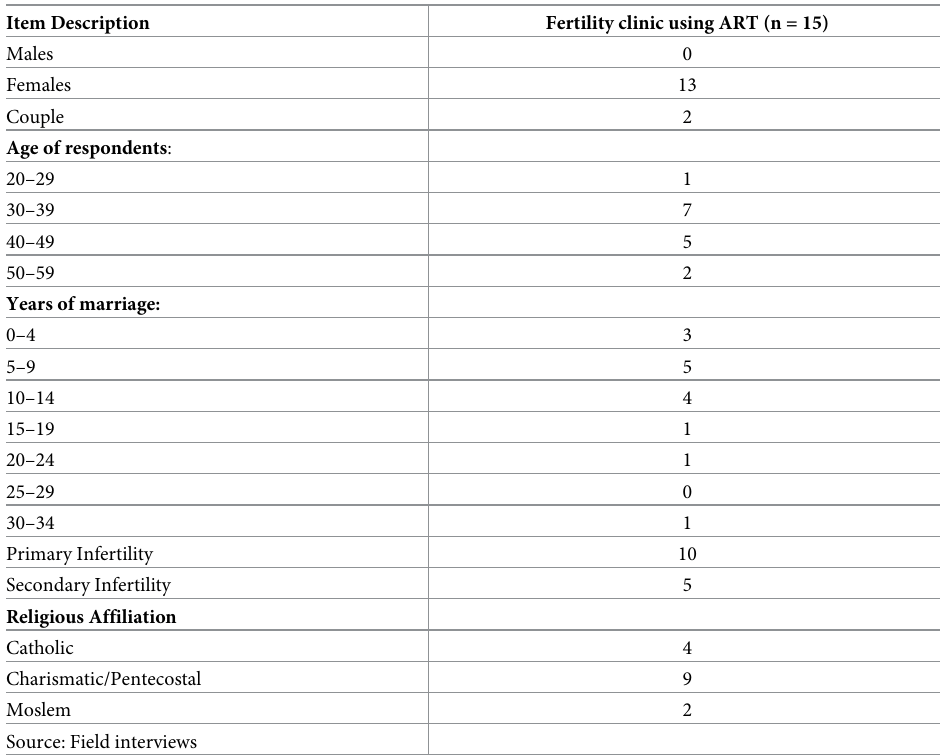
Table 1. Socio-demographic characteristics of